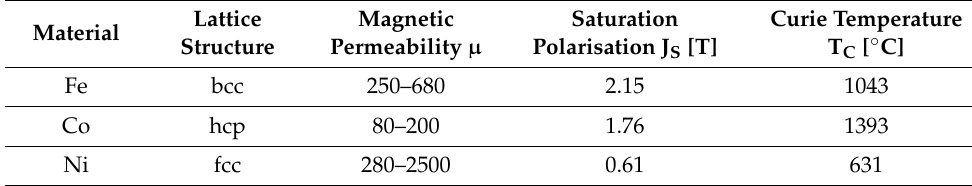
Table 1. Magnetic properties of Fe, Co, and Ni [26–29].